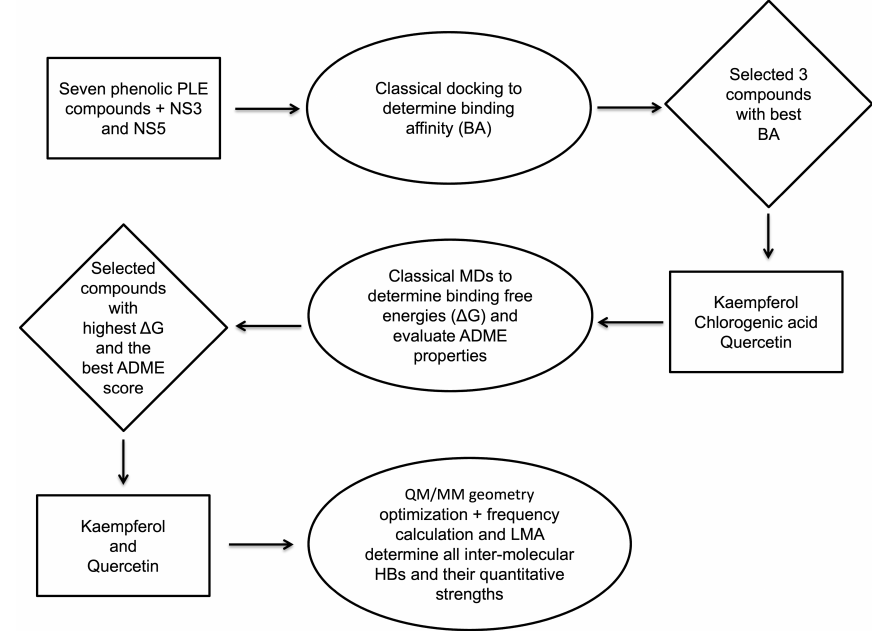
Figure 2. Flow chart of the dengue